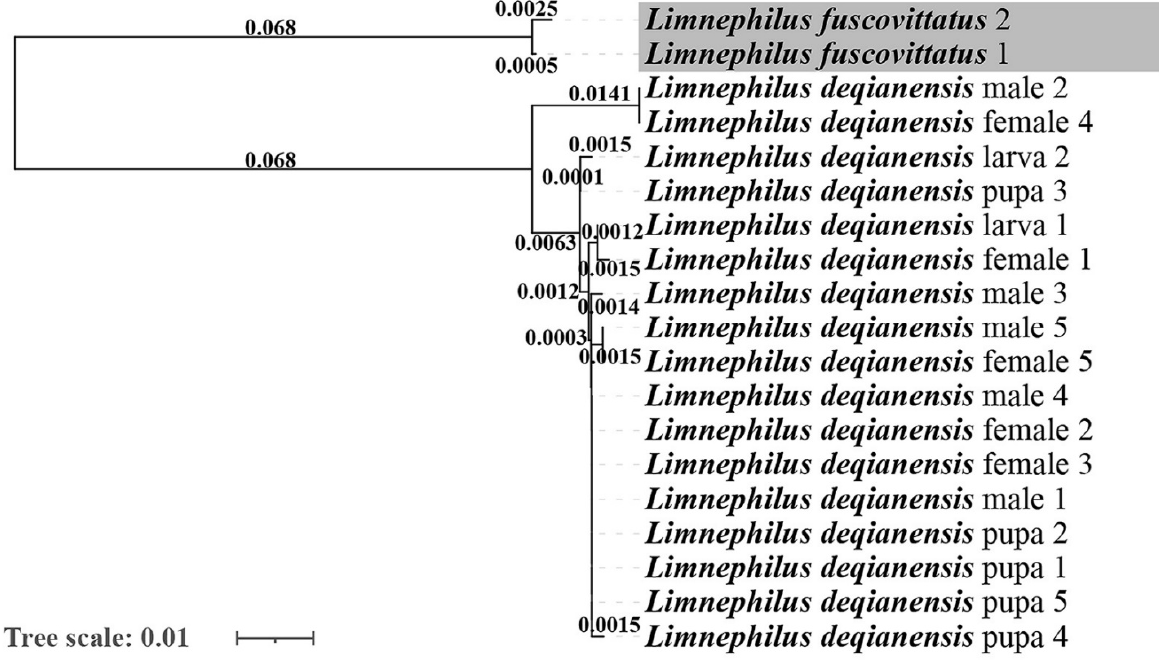
Figure 14. Neighbor-joining diagram based on sequenced data of the mitochondrial COI used to determine larva/female/male/pupa associations of Limnephilus deqianensis n. sp. Tree scale measures genetic